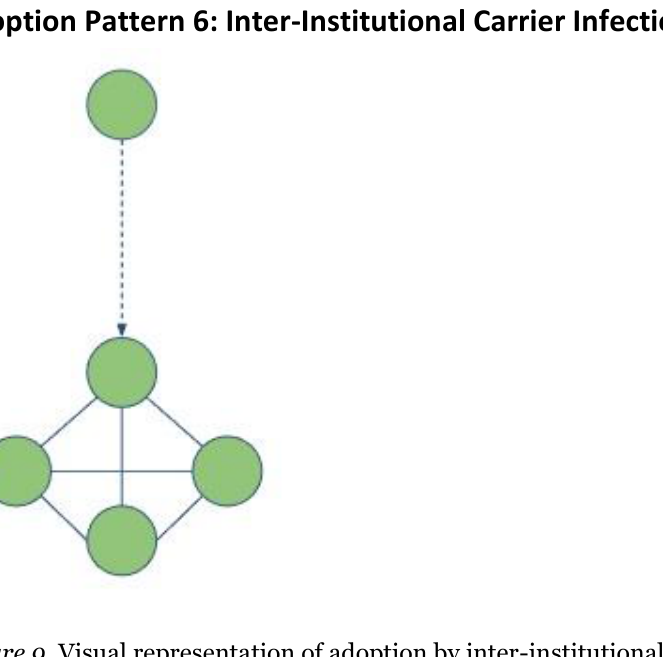
Figure 9. Visual representation of adoption by inter-institutional carrier